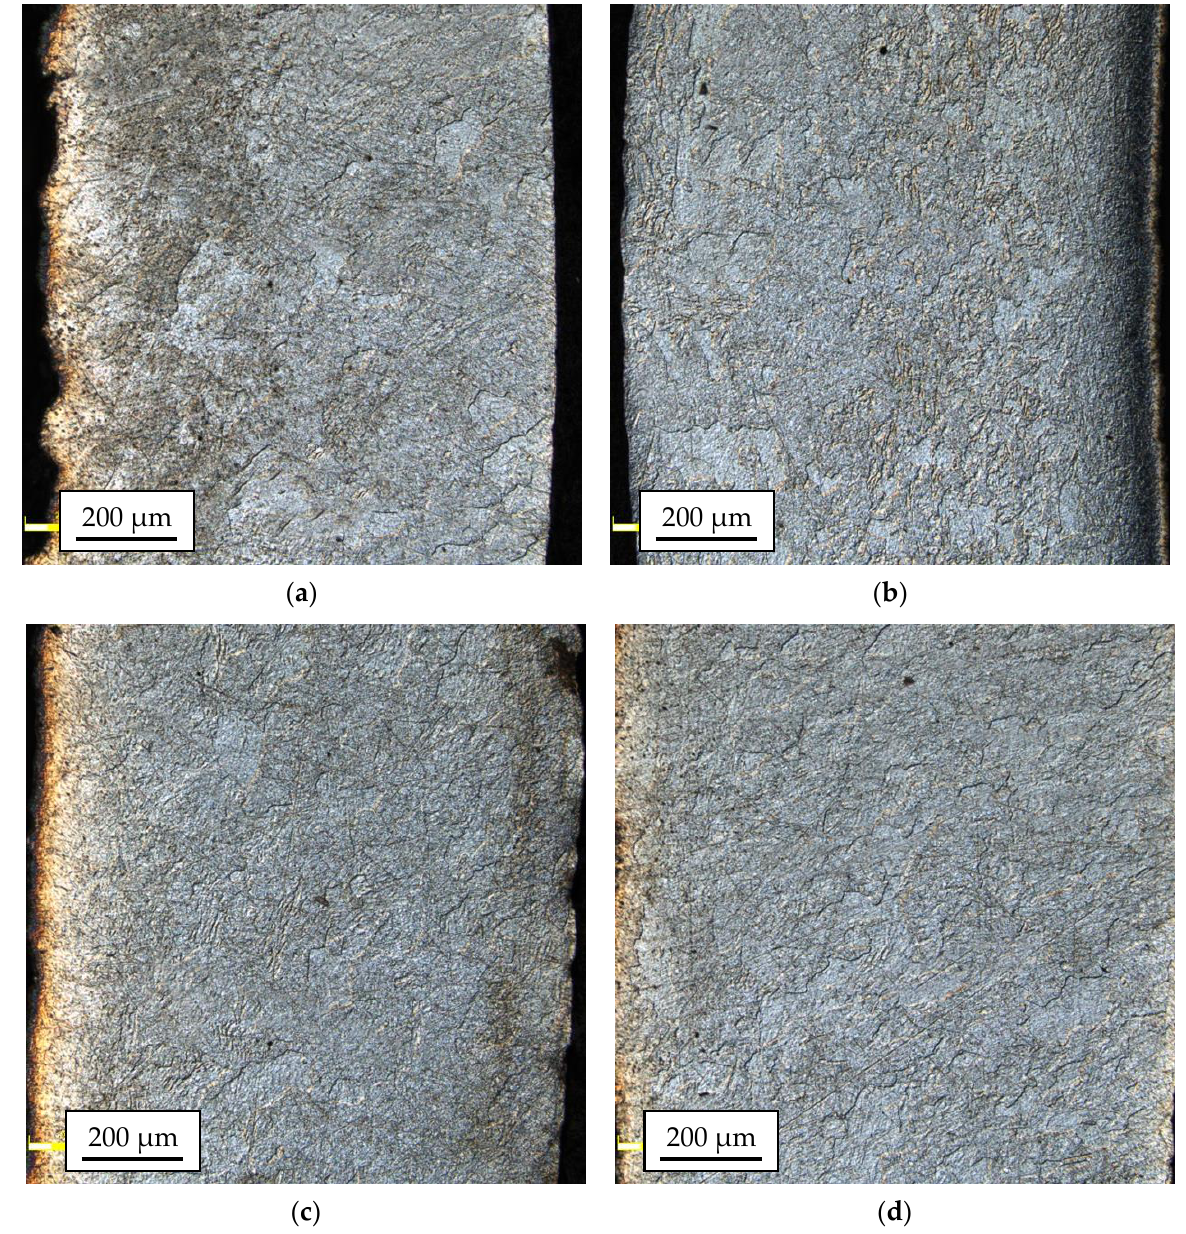
Figure 9. The 1050A microstructure after rolling in classic passes (variant I), temperature of 300 °C ( a ); modified passes (variant II), temperature of 300 °C ( b ); classic passes (variant I), temperature of 400 °C ( c ); modified passes (variant II), temperature of 400 °C ( d ).